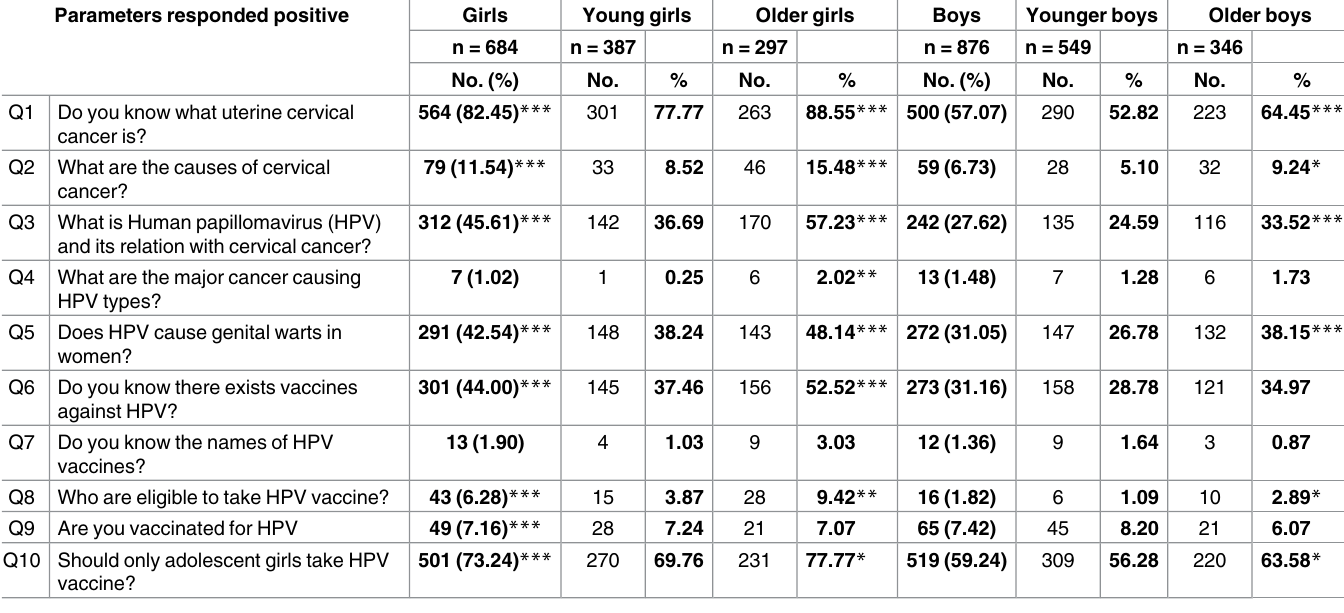
Table 2. Knowledge about cervicalcancer and HPV among college students based on their sex. Parameters responded